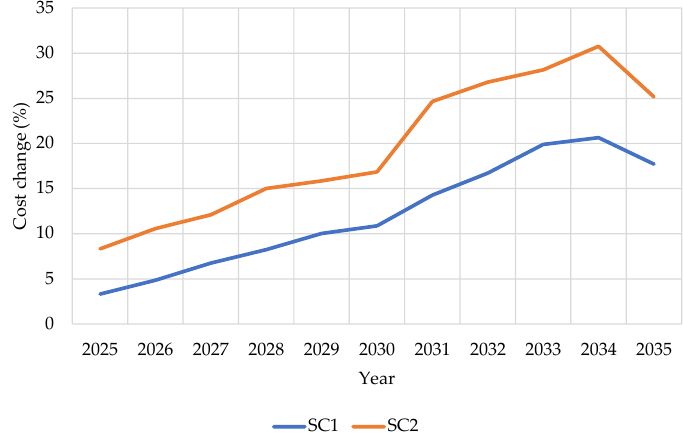
Figure 10. Cost change (%) in the case of the loss of wind generators.